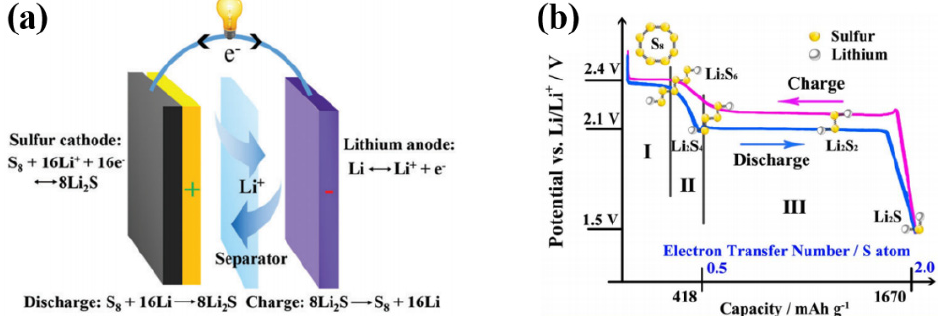
Figure 1. ( a ) Schematic of the electrochemistry, reprinted from [3]. Copyright 2016 with permission from Royal Society of Chemistry. ( b ) Charge-discharge profiles of Li-S batteries, reprinted from [4]. Copyright 2016 with permission from Elsevier.